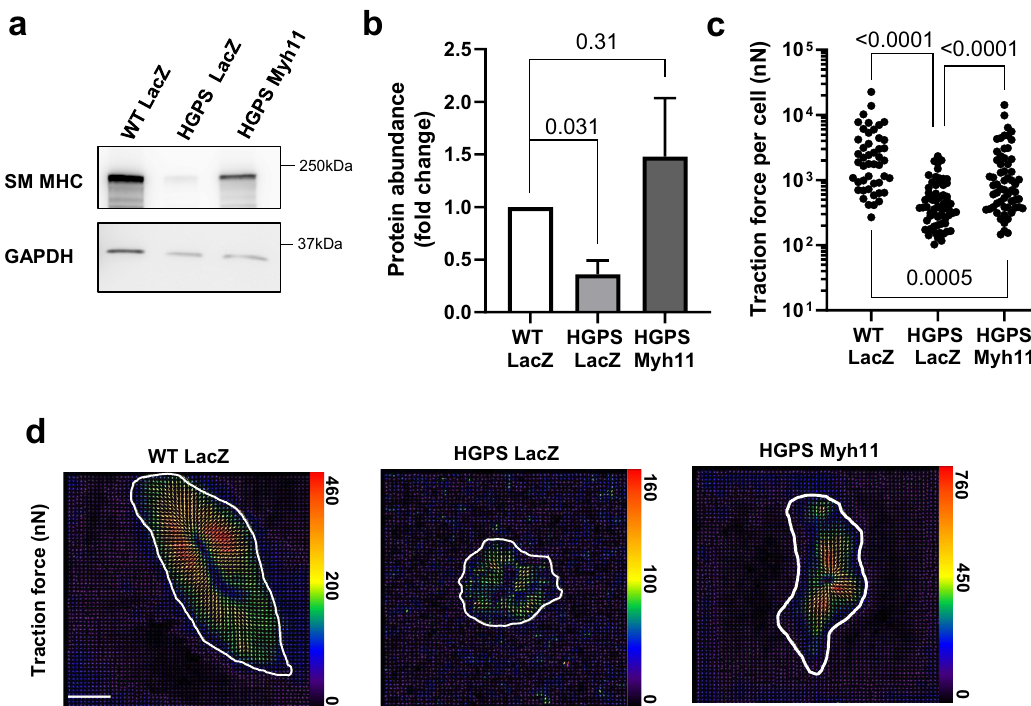
Figure 5. Smooth muscle myosin heavy chain overexpression restores contractility in isolated HGPS smooth muscle cells. Aortic SMCs isolated from 2-month WT and HGPS mice were incubated with adenovirus encoding LacZ (control) or Myh11 for 72 h. ( a ) Representative images of lysates from the infected cells immunoblotted for SM-MHC and GAPDH (loading control). Black boxes around the immunoblots indicate cropping for the removal of extraneous space. Unprocessed blots are shown in Fig. S1. ( b ) Quantification of immunoblotting results normalized for loading and plotted relative to the WT LacZ control . Results show mean ± SE (n = 6). Significance was determined by Wilcoxon signed rank test. ( c ) Total traction force plots of primary WT and HGPS aortic SMCs incubated with an adenovirus encoding LacZ or Myh11 (n = 47–65 cells). Each dot represents the total traction force of a single cell. Significance was determined by Mann–Whitney tests. ( d ) Representative traction force images of cells analyzed in panel c. Cell areas are outlined in white, and traction force scale bars (in nanonewtons) are displayed to the right of each respective image. Optical scale bar = 50